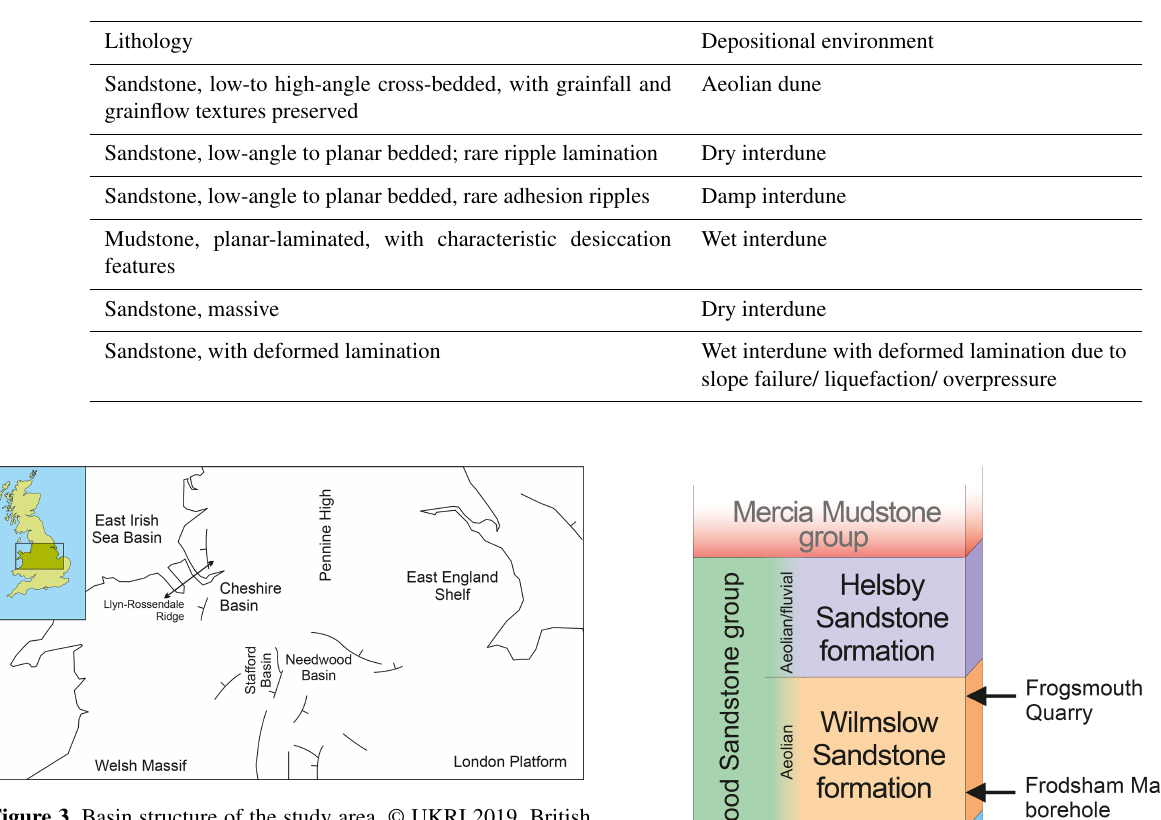
Table 1. Facies scheme used to classify Triassic sandstones in borehole and outcrops in north Cheshire, this study considers only the aeolian facies. All massive sandstones have been attributed to dry interdunes but these may include minor components of aeolian dunes.